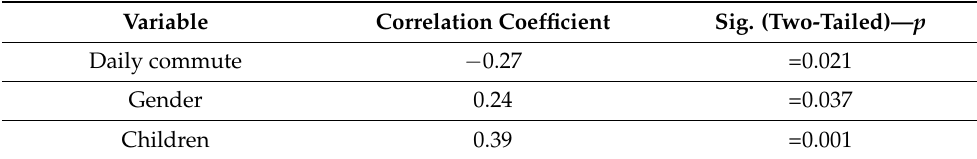
Table 6. Correlation of different factors with depersonalization.